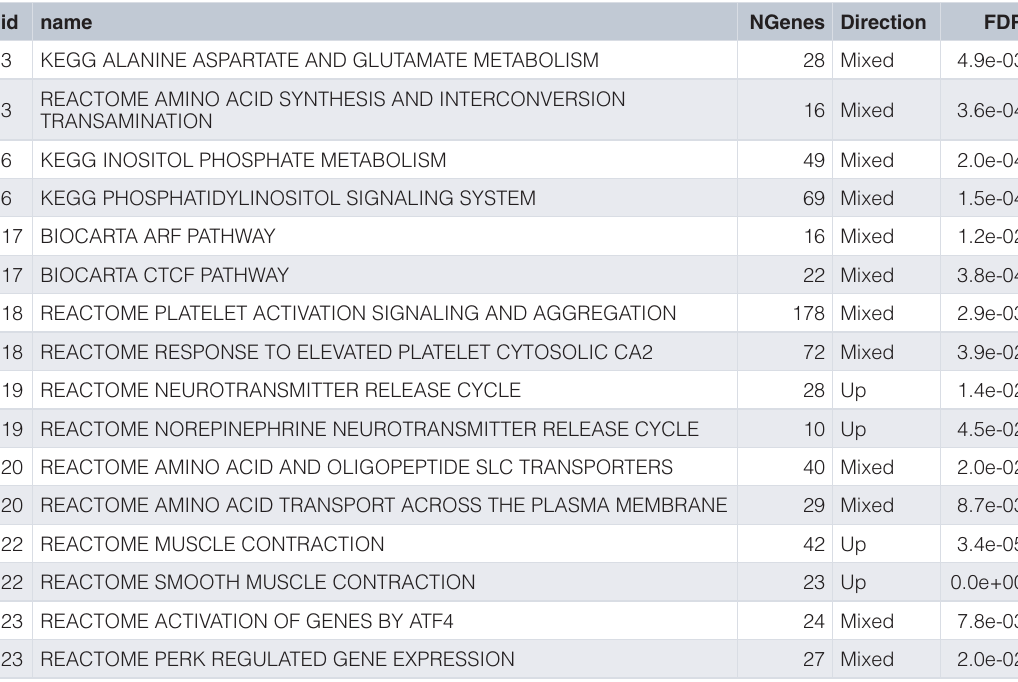
Table 2. List of binary clusters as indicated by the id